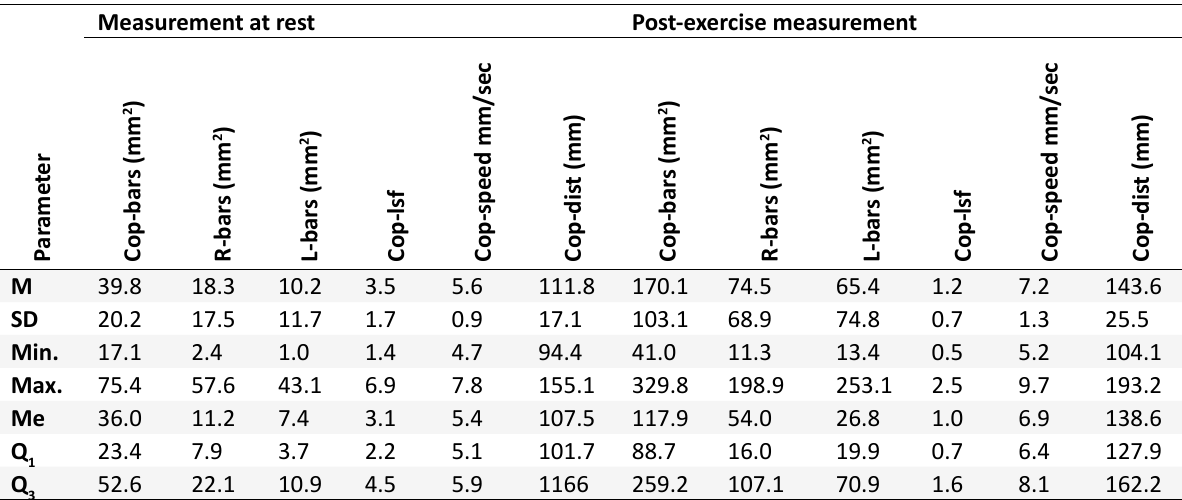
Legend: Cop-bars – surface of deflections of the body’s centre of gravity , R-bars – right foot deflection area, L-bars – left foot deflection area, Cop-lsf – ratio of the distance between extreme deflections to the deflection surface, Cop- speed – deflections speed of body’s centre of gravity, Cop-dist – distance between extreme deflections of the body’s centre of gravity, M – the arithmetic mean of a sample, SD – standard deviation, Min . – minimum value of a